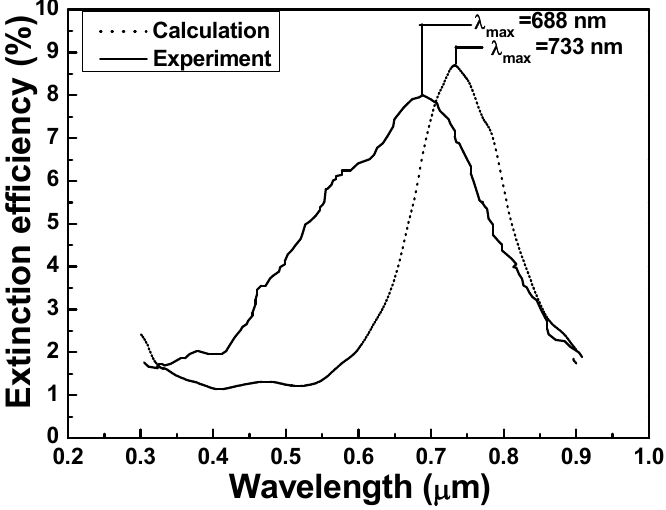
Figure 7. Extinction spectra of experiment and calculation with 1.68 refractive index